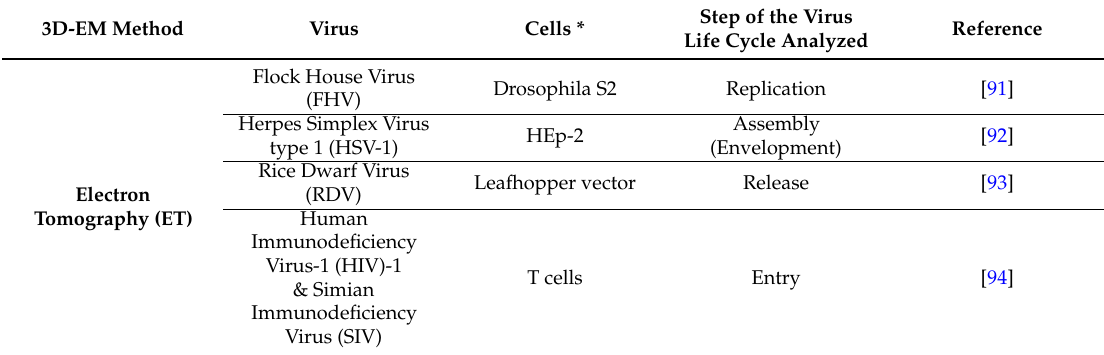
Table 1. Summary of the EM methods used to reconstruct the 3D architecture of virus-infected